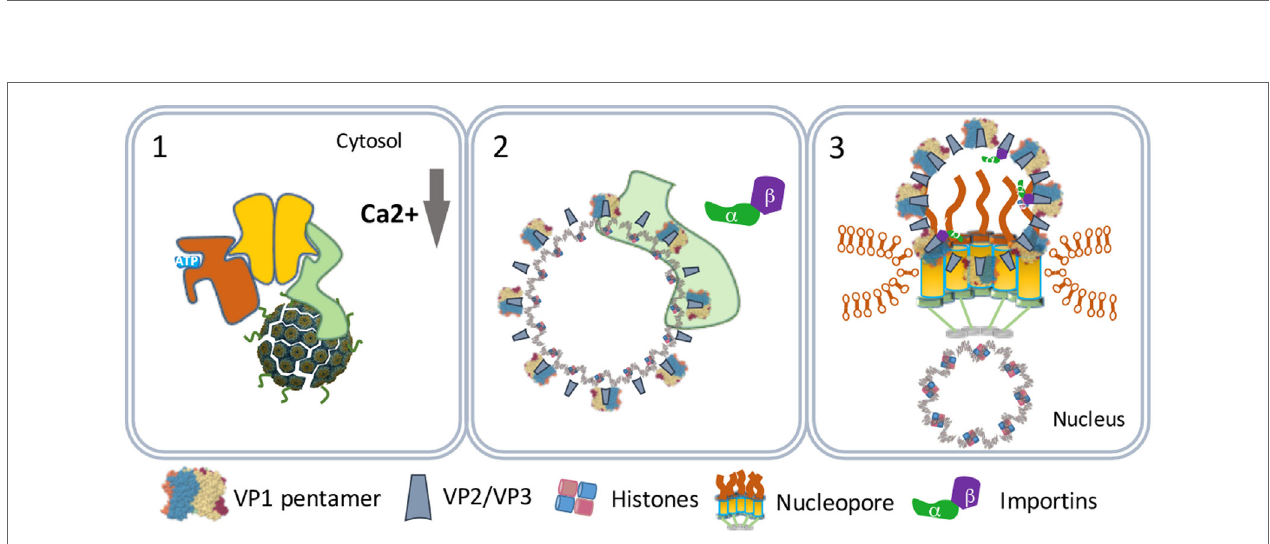
FigURe 5 | SV40 nuclear entry. SV40 particles further destabilize by low calcium in the cytosol (1) and lose VP1 by cytosolic chaperones (2). The particles bind nucleopores and viral genomes enter the nucleus